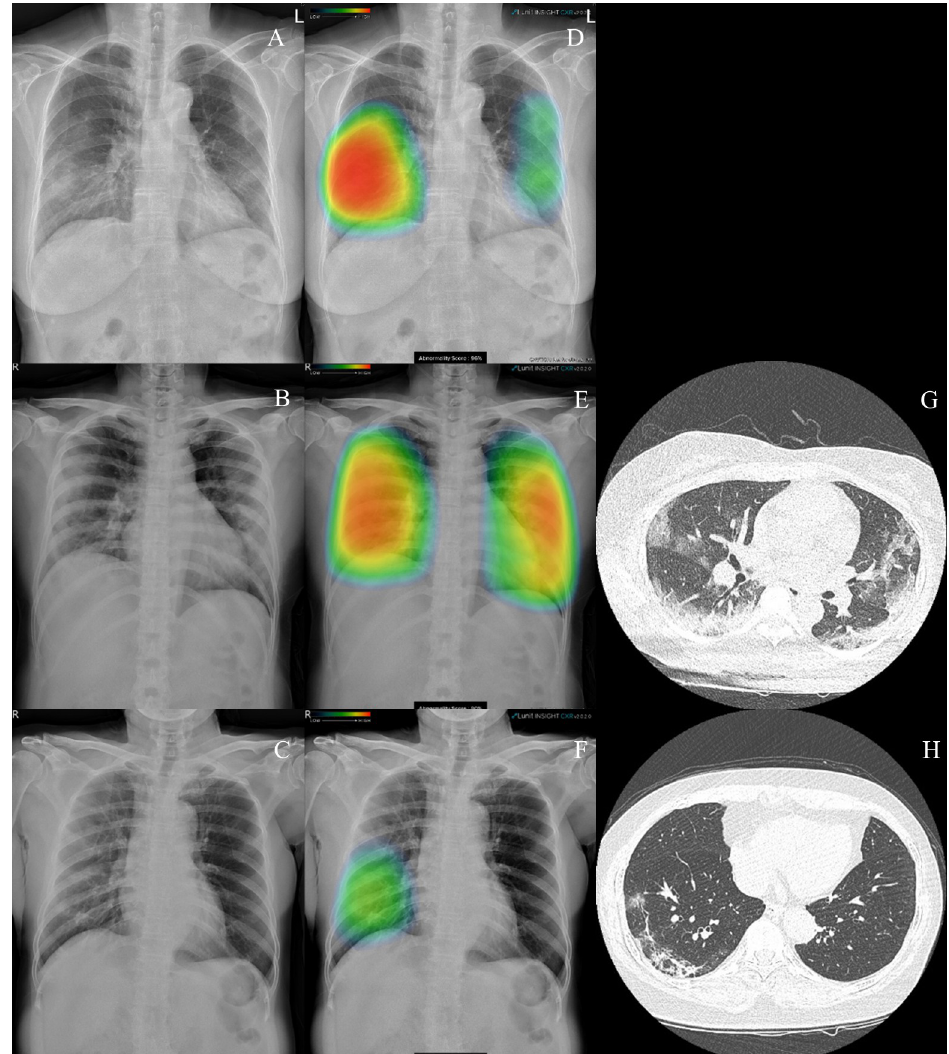
Fig 2. Results of the deep learning (DL) algorithm analysis of the localization of COVID-19 with pneumonia. (A, B, C) Chest radiography (D, E, F) DL algorithm heatmap overlaid on the image feature related to pneumonia. (G, H) Computed tomography scan, showing lung consolidation and ground-glass opacities that are suitably localized and detected by the DL